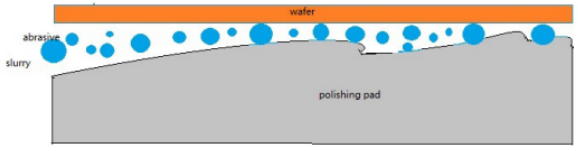
Figure 2: Micro-structure of the contact of